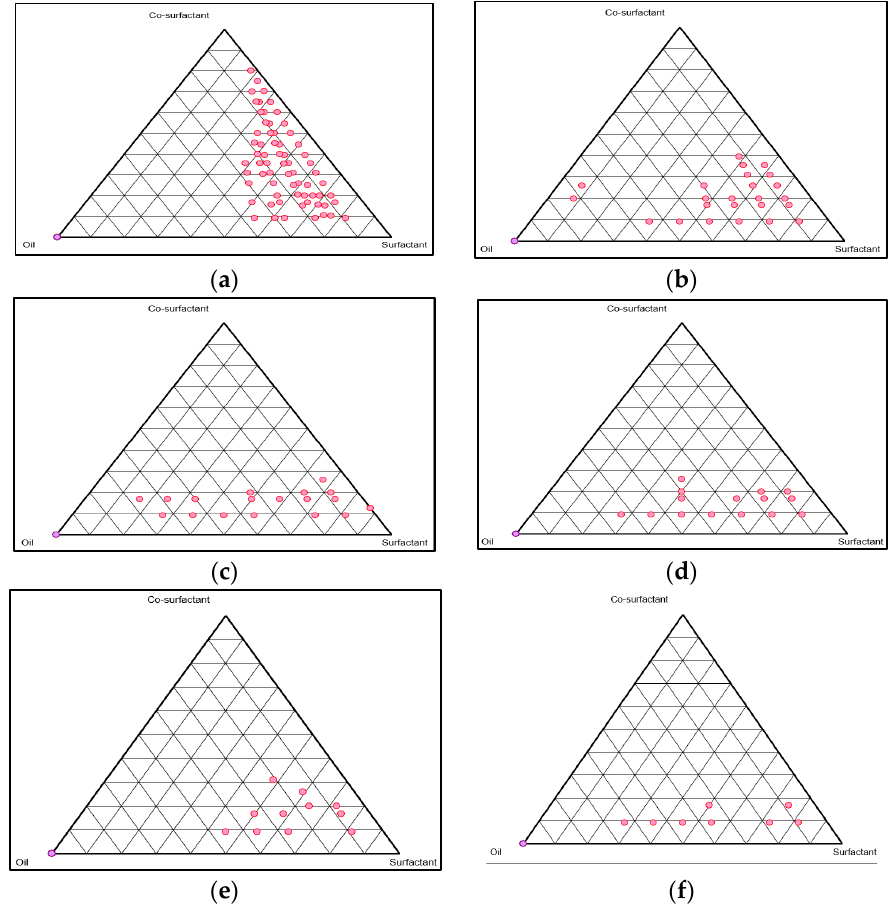
Figure 1. Pseudoternary phase diagrams displaying the area of nanoemulsion of Smix. ( a ) 3:1 (Se ‐ lected ratio for Smix). ( b ) 4:1. ( c ) 5:1. ( d ) 2:1. ( e ) 1:0. ( f ) 1:1. (Selected ratio for Smix). ( b ) 4:1. ( c ) 5:1. ( d ) 2:1. ( e ) 1:0. ( f )